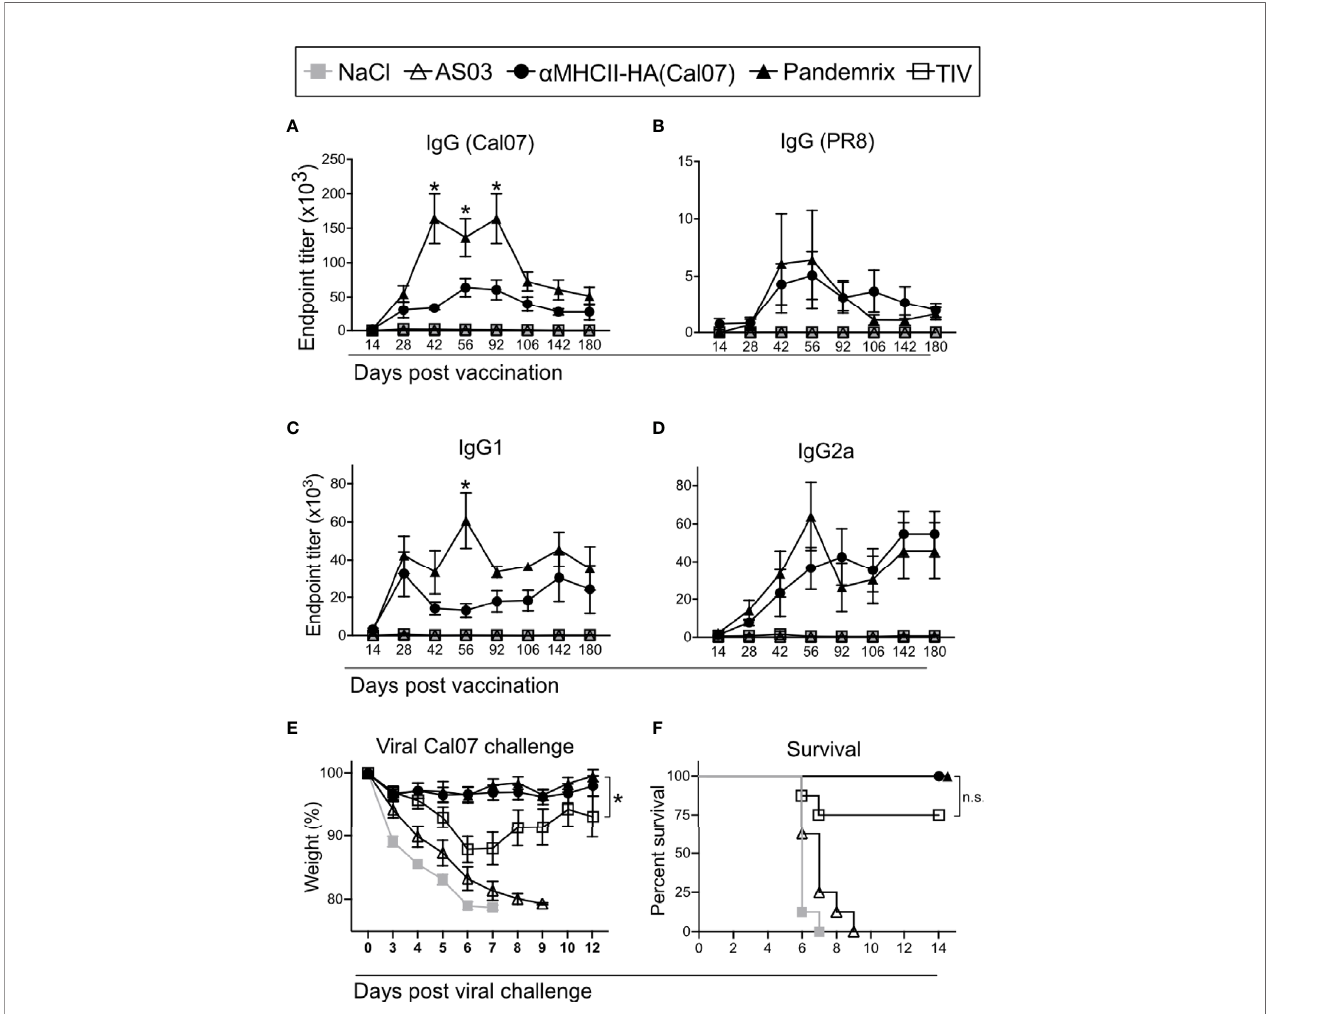
FIGURE 1 | Long term antibody responses and protection after a single vaccination. Mice (n=8/group) were vaccinated i.m. with the indicated vaccines. (A – D) Serum antibodies were monitored up to 6 months after vaccination in ELISA for (A) total IgG against HA from Cal07, (B) total IgG against HA from PR8, (C) IgG1 against HA from Cal07, and (D) IgG2a against HA from Cal07. *P < 0.05 for a MHCII-HA versus Pandemrix. (E, F) At 180 days after vaccination, mice were challenged with 5xLD 50 dose of Cal07. (E) Weight was monitored. (F) Survival curve after challenge, de fi ned by 20% weight loss. (A – E) Data shown are mean ± SEM, *P < 0.05 (two-way ANOVA) (F) *P < 0.05 (Gehan-Breslow-Wilcoxon test). n.s., not signi fi